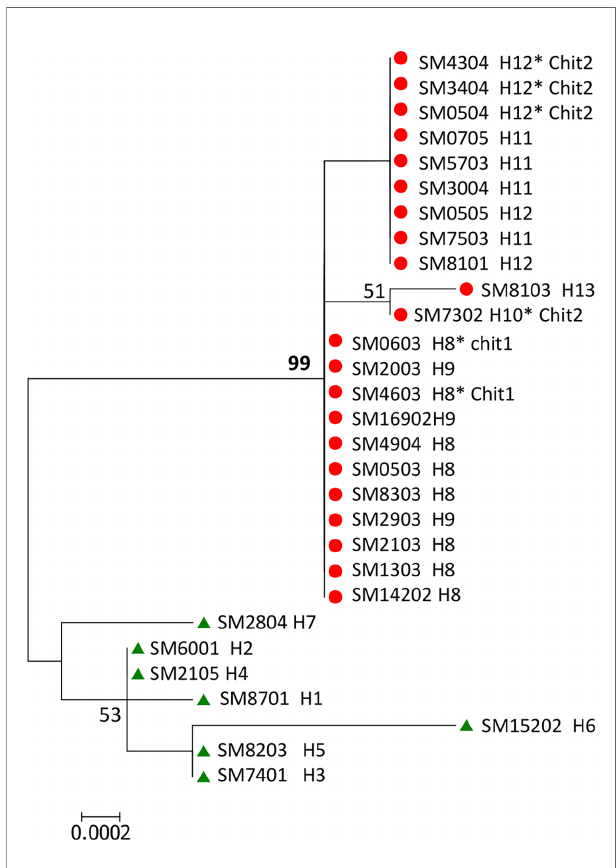
FIGURE 1 | ML phylogenetic tree of Plasmodium vivax gene sequences of ookinete proteins de fi ned two parasite lineages in southern Mexico.